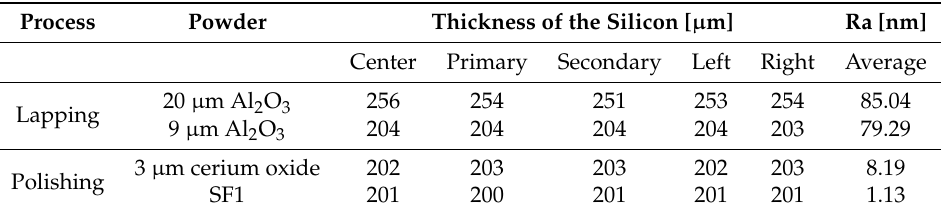
Table 1. Process parameters for chemical mechanical polishing (CMP).